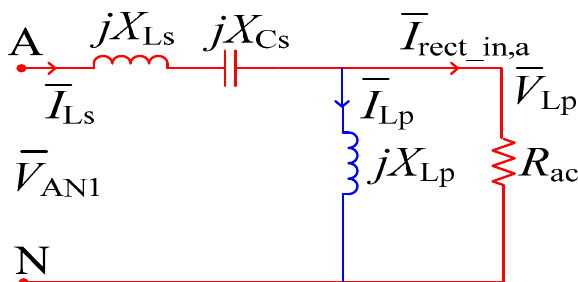
Figure A1. Phasor equivalent circuit used for analyzing Module 1 of the converter shown in Figure 3 [24,25].